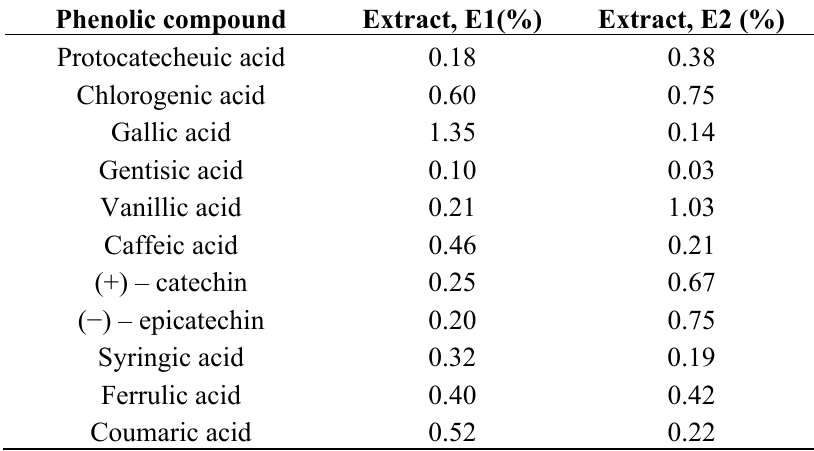
Table 5. Chemical profile of the supercritical extracts from Satureja Montana (relative